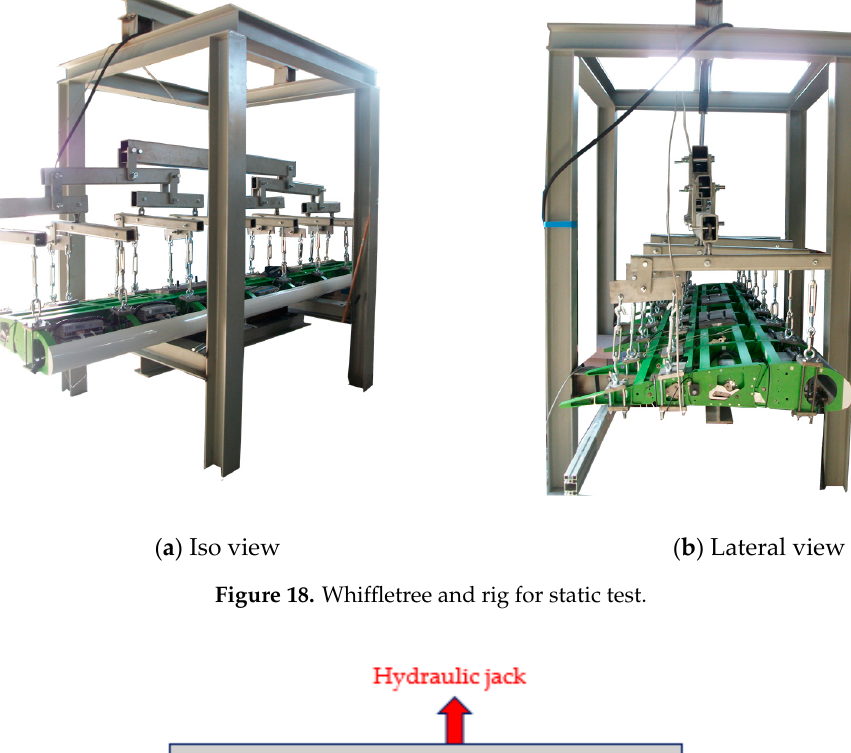
Figure 17. ( a ) pressure distribution at limit design condition; ( b ) lumped forces distribution along blocks B0, B2, B3 equivalent to the pressure distribution at limit design load condition; ( c ) histogram of the equivalent lumped forces distribution applied during tests (blocks B1, constrained).